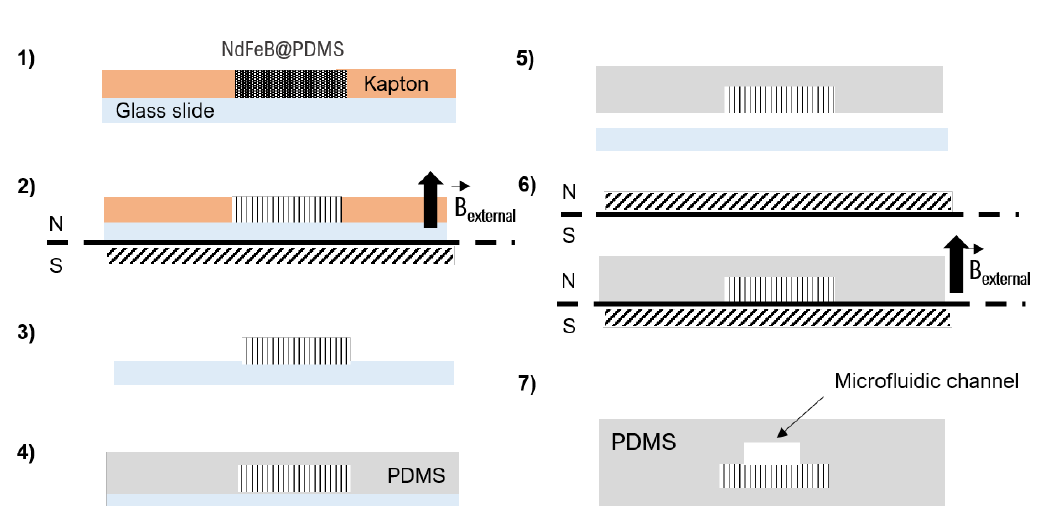
Figure 1. Fabrication steps of the microdevice: ( 1 ) the composite is molded in a Kapton film bonded to a silanized glass slide substrate; ( 2 ) the composite is then placed in a 300 mT magnetic field for NdFeB particle self-organization in chains at 60 °C for 2 h; ( 3 , 4 ) the Kapton mold is then removed and pure PDMS is poured; ( 5 ) after curing at 70 °C for 2 h, the composite membrane is peeled off and ( 6 ) magnetized under a magnetic field of 1 T. Finally, ( 7 ) the composite membrane is bonded to a channel molded in PDMS by O 2 surface plasma activation.